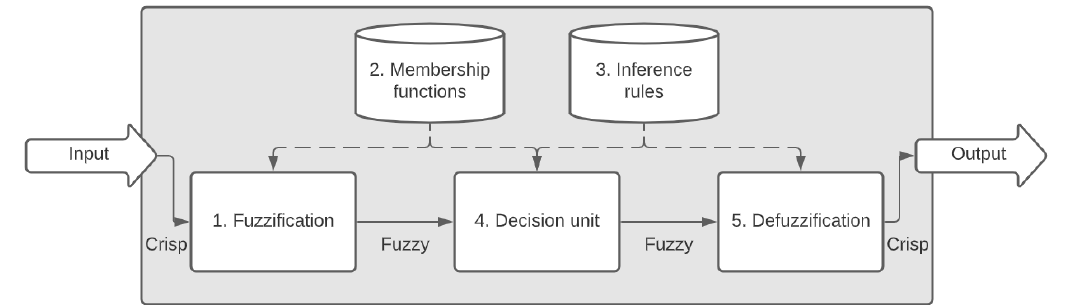
Figure 2. Fuzzy inference